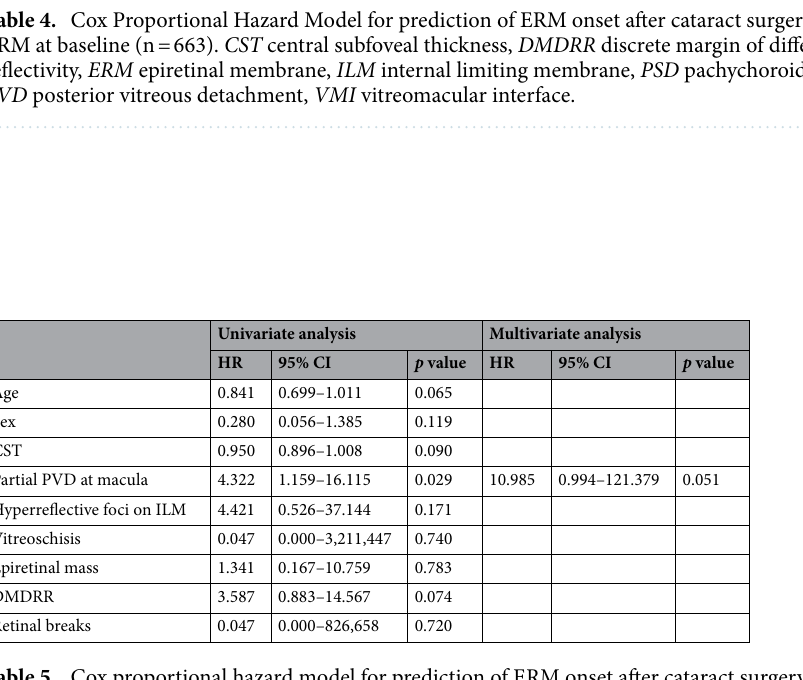
Table 5. Cox proportional hazard model for prediction of ERM onset after cataract surgery in eyes with mild ERM at baseline (n = 150). CST central subfoveal thickness, DMDRR discrete margin of different retinal reflectivity, ERM epiretinal membrane, ILM internal limiting membrane, PSD pachychoroid spectrum disease, PVD posterior vitreous detachment, VMI vitreomacular interface.